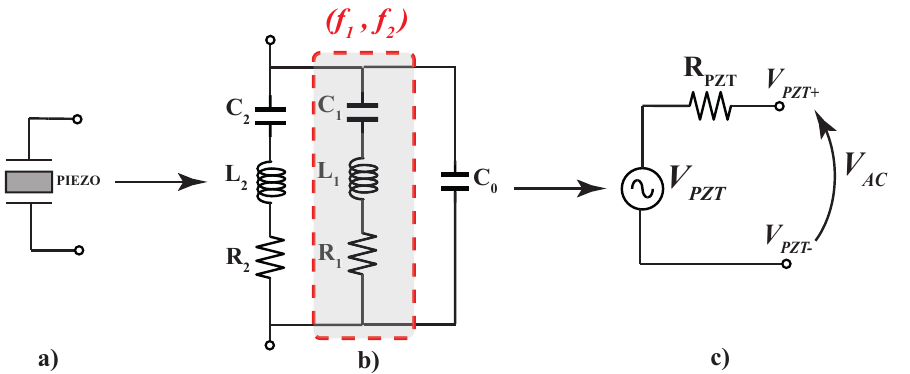
Figure 5. ( a ) The piezoelectric device, ( b ) BDV model with two resonance doublets, and ( c ) its equivalent Thévenin model assuming electric resonant